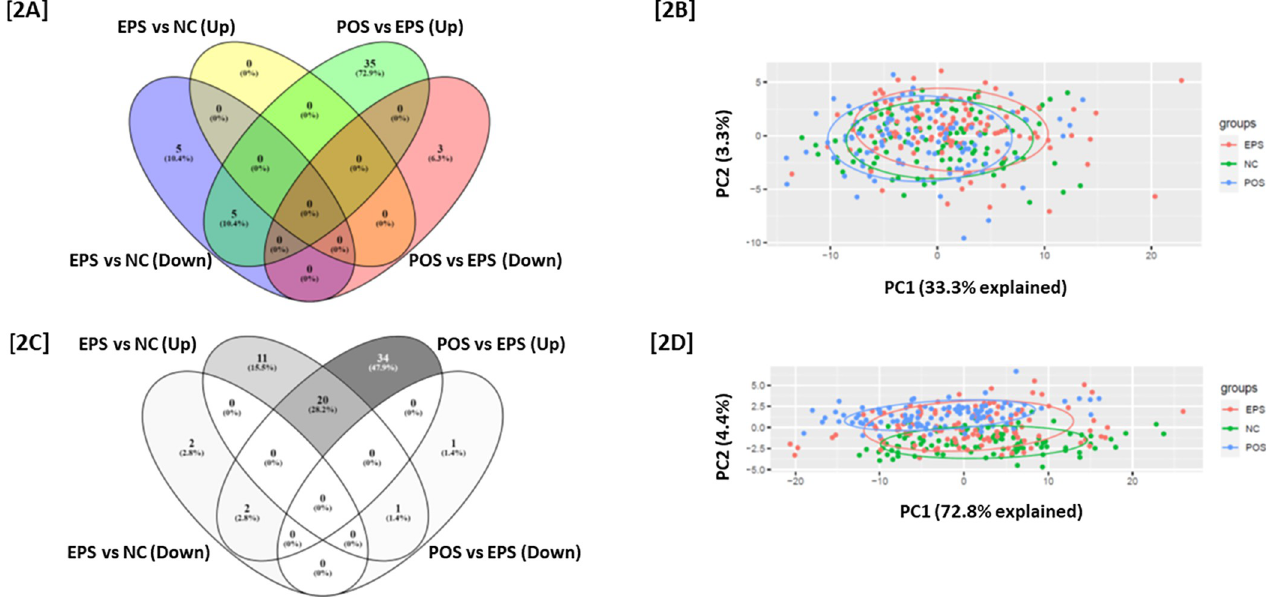
Fig 2. Patients with EPS showed significant increased IgM autoantibodies but not IgG autoantibodies compared with NC group (A) Venn diagram showing none is overlap between EPS versus NC and POS versus EPS (B) PCA of combined IgG autoantibodies showing clustering of POS difference from NC and EPS (pairwise Adonis test with adjusted p values for FDR: POS versus NC, p = 0.003; POS versus EPS, p = 0.003). EPS cluster is closer to NC cluster (adjusted p value by Adonis test is 0.035) (C) Venn diagram showing 20 elevated IgM antigens recognized all by EPS versus NCs and POS versus NC. (D) PCA of combined IgM autoantibodies showing clustering of POS difference from NC and EPS (pairwise Adonis test with adjusted p values for FDR: POS versus NC, p = 0.003; POS versus EPS, p = 0.003). EPS cluster is closer to NC cluster (adjusted p value by Adonis test is 0.027).